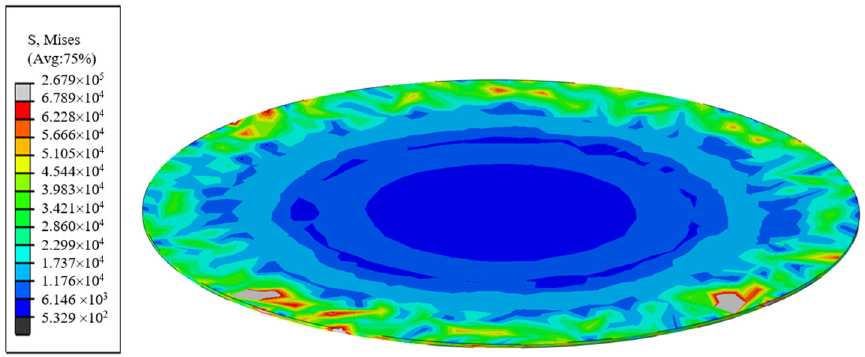
Figure 9. Axial compressive stress nephogram on the pressboard of group TEM11 at the moment of 1.05 s.